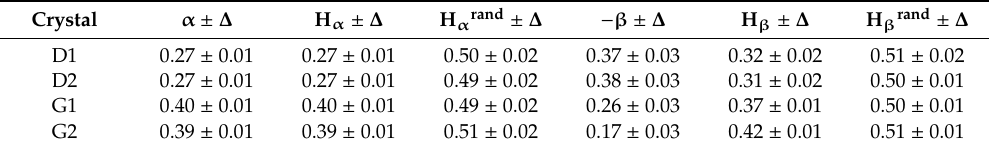
Table 1. Parameters ( α , β ), Hurst exponents (H), and standard errors ( ∆ ), calculated by